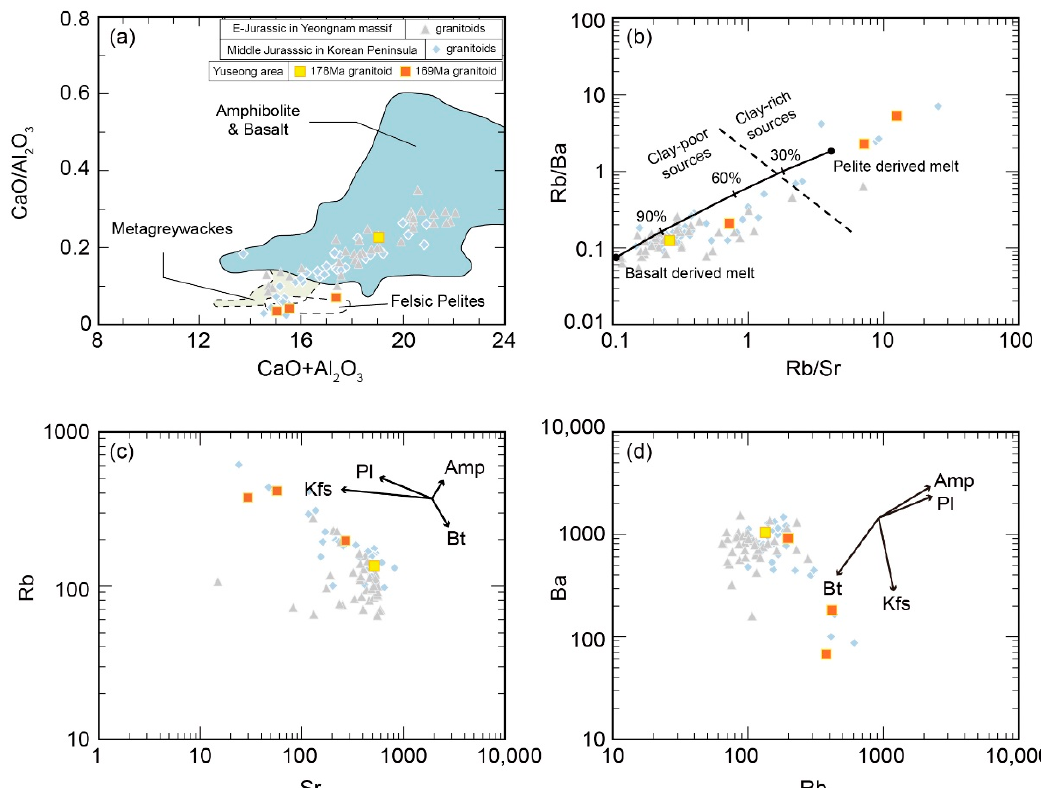
Figure 8. Binary plots for the Middle Jurassic granitoids in the Yuseong area, Early Jurassic granitoids in the YM, and Middle Jurassic granitoids in the Korean Peninsula in the ( a ) CaO/Al 2 O 3 vs. CaO + Al 2 O 3 (after Douce [51]), ( b ) Rb/Ba vs. Rb/Sr (after Douce and Harris [52], Sylvester [53]), ( c ) Rb vs. Sr, and ( d ) Ba vs. Rb diagrams. The mineral fractionation paths are calculated using the mineral/melt partition coefficient suggested by Hanson [54]. Pl: plagioclase; Kfs: K-feldspar; Amp: amphibole; Bt: